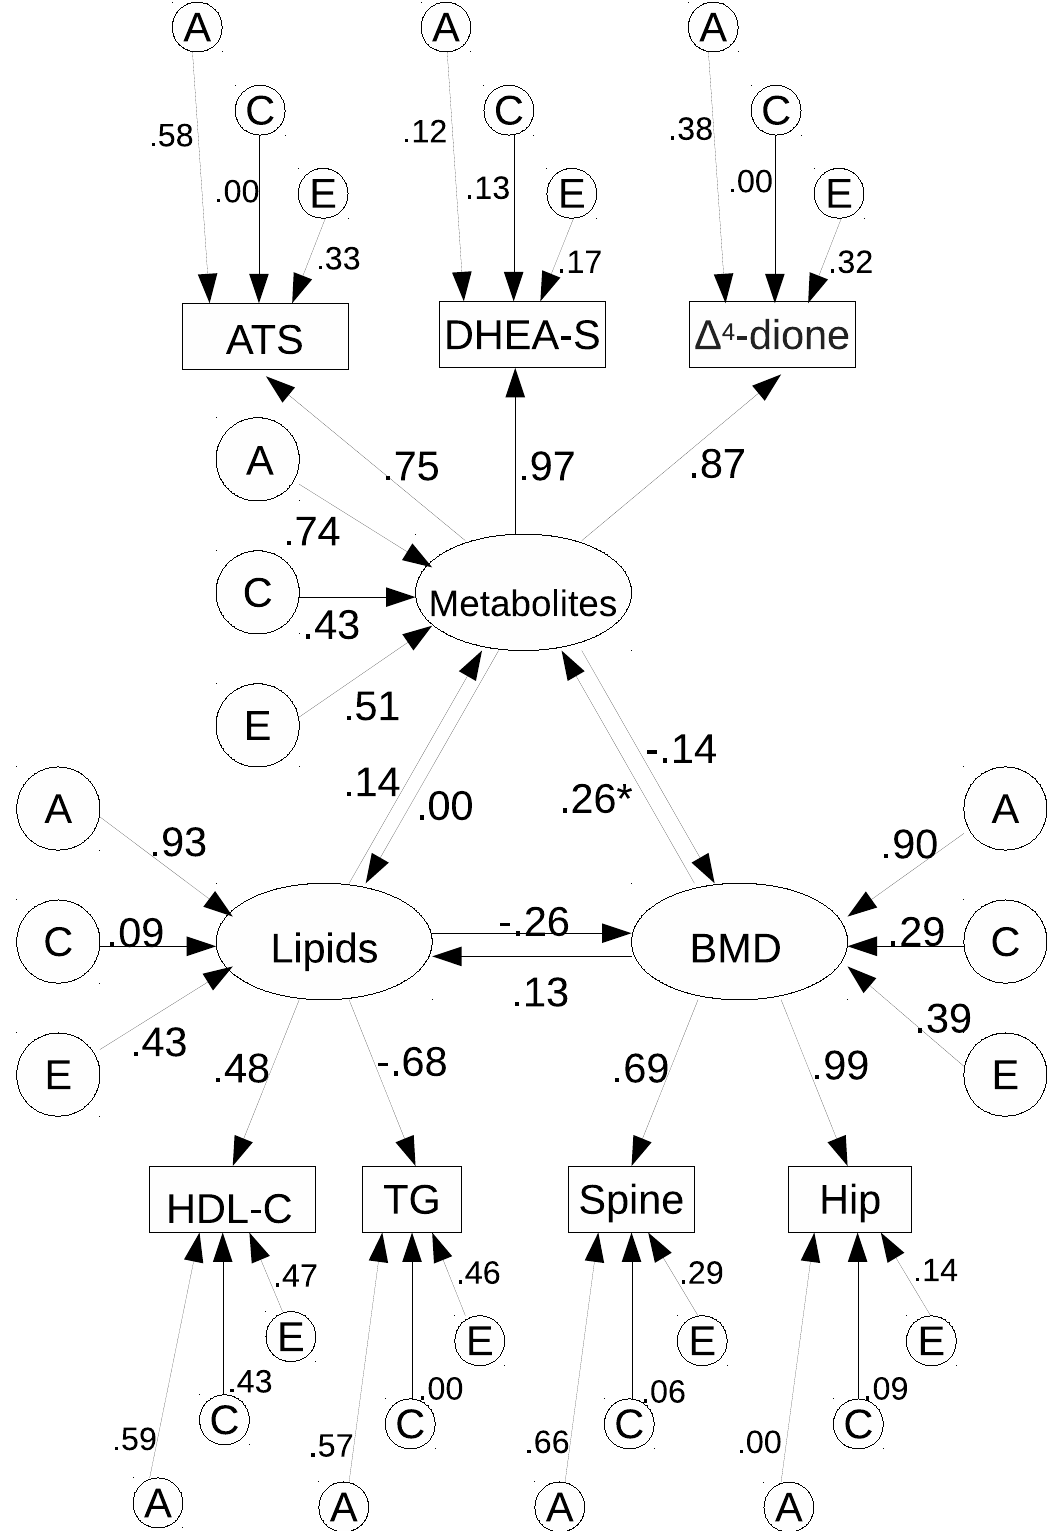
Fig 2. Path diagram of reciprocal causation twin model. Depiction is only for a single individual, including standardized parameter estimates from fitting the full model. For further explanations please see text. https://doi.org/10.1371/journal.pone.0212464.g002 PLOS ONE | https://doi.org/10.1371/journal.pone.0212464 February 22,